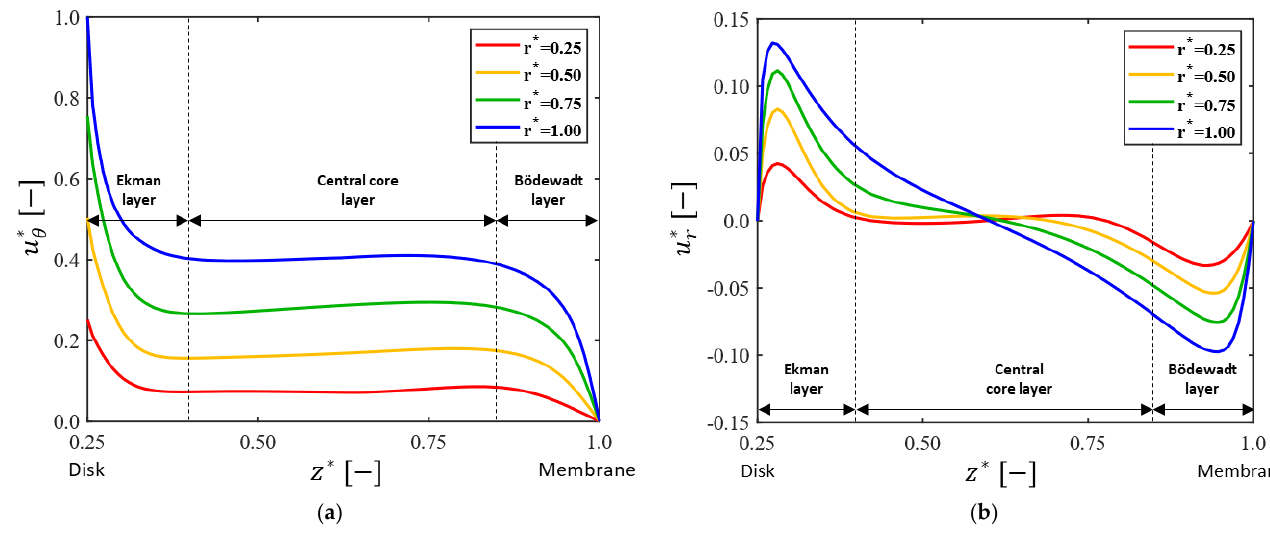
Figure 5. The dimensionless circumferential and radial velocity profiles for the plain disk case (P00). Velocity profiles in the dimensionless axial direction are plotted at the four locations on the 𝑦 -axis with the dimensionless radial distance 𝑟 ∗ = 0.25, 0.5, 0.75, and 1. Here, the angular velocity of the disks is 𝛺 = 200 rpm. The two velocity components are defined by 𝑢 𝜃∗ = 𝑢 𝜃 /𝑈 and 𝑢 𝑟∗ = 𝑢 𝑟 /𝑈 , where 𝑈 = 𝑅 𝑖 𝛺 . ( a ) Dimensionless circumferential velocity ( 𝑢 𝜃∗ ); ( b ) dimensionless radial velocity ( 𝑢 𝑟∗ ). In the two plots, 𝑧 ∗ = 0.25 corresponds to the disk surface and 𝑧 ∗ = 1 to the mem- brane surface.